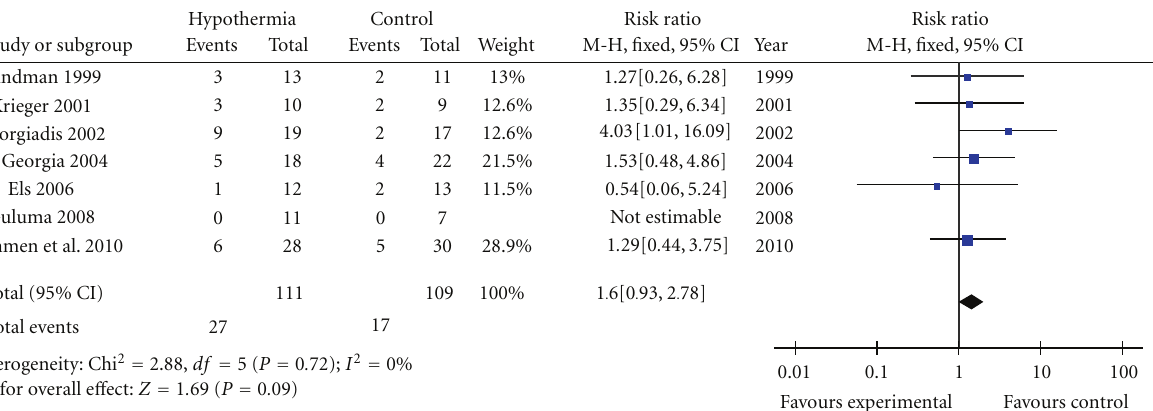
(95% CI: − 0.42 to 0.08; P = 0 . 32). The mortality was similar for stroke patients who underwent hypothermia and controls, with a pooled risk ratio of 1.60 (95% CI: 0.93 to 2.78; P = 0 . 11). The results of the e ff ect size meta-analysis for the clinical outcome should be taken with caution due to high inconsistency/heterogeneity ( I 2 = 73%; Chi 2 = 21 . 89, P = 0 . 0001); the results of the relative risk meta analysis for the patients mortality are perfectly consistent ( I 2 = 0%; Chi 2 = 2 . 88, P = 0 .